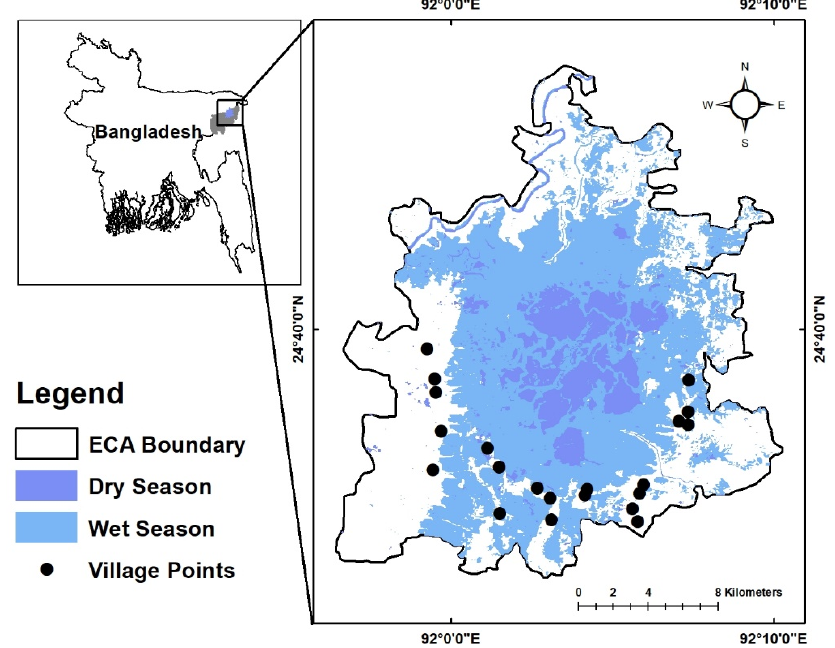
Figure 1. The Ecologically Critical Area (ECA) of Hakaluki Haor. Water level differences between the dry season (February 2017) and wet season (September 2017; highest and lowest water levels, respectively).